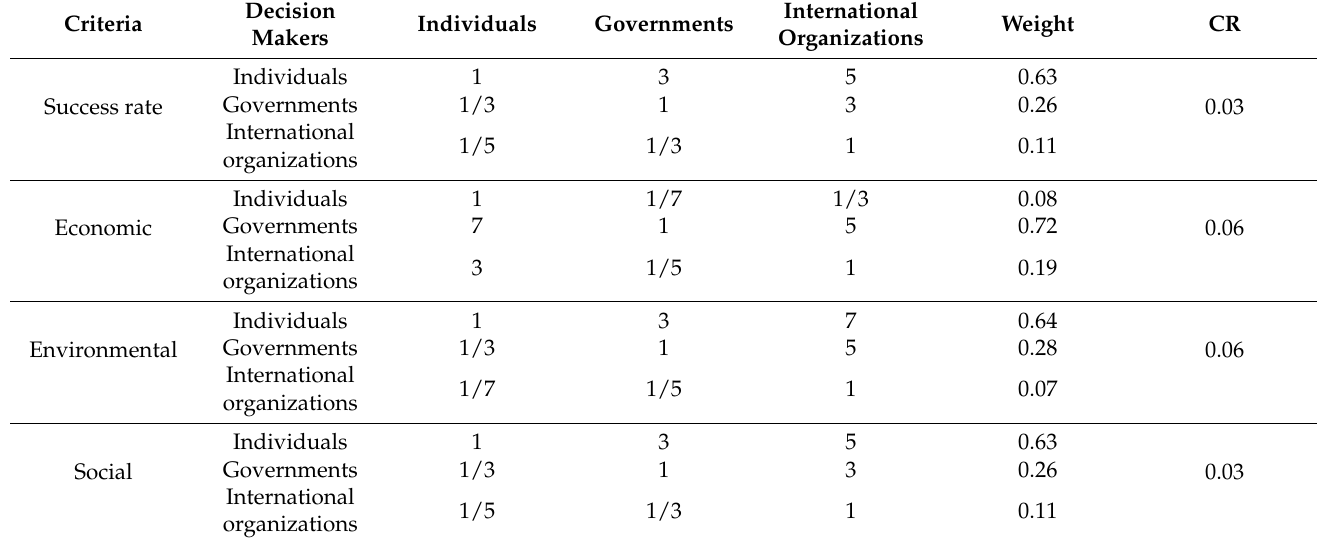
Table 9. Pairwise comparison matrix of decision makers.